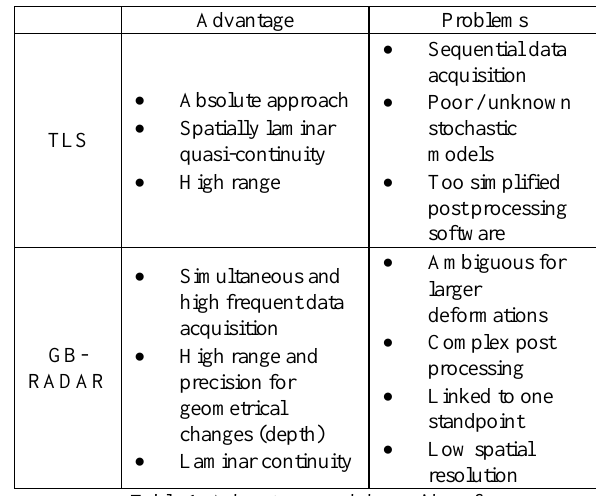
Table 1: Advantages and downsides of TLS and GB-RADAR systems